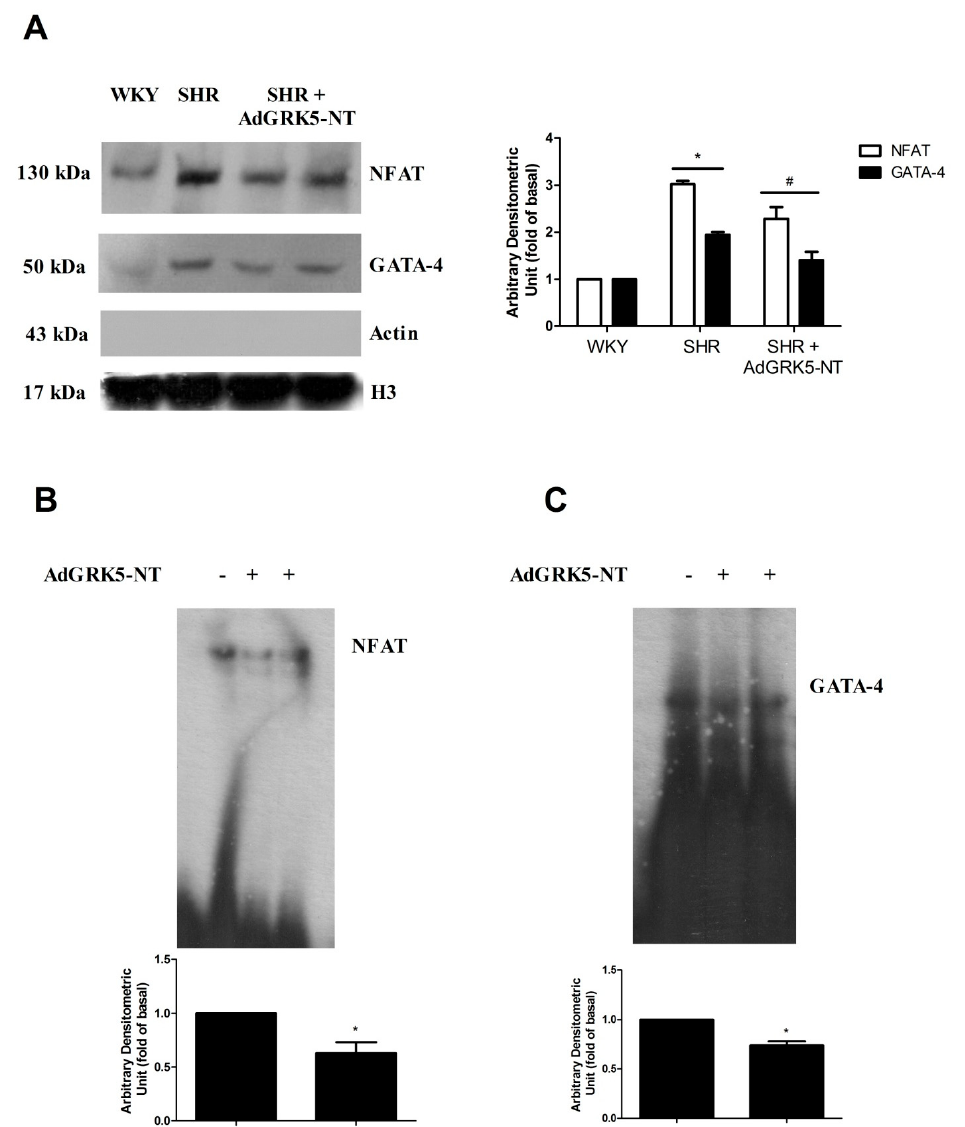
Figure 4. The amino-terminal domain of the G Protein Coupled Receptor Kinase 5 (GRK5-NT) regulates NFAT and GATA-4 activity in vivo. ( A ) The nuclear translocation of NFAT and GATA-4 was evaluated by immunoblot in rat hearts. In hypertrophic SHR rats, there was a significant accumulation of NFAT and GATA-4 in nuclear extracts respect to WKY. The treatment with AdGRK5-NT significantly reduced nuclear translocation of these factors. Densitometric analysis is shown in bar graph as mean ± SD. Actin was used as control of nuclear extracts purity; * p < 0.05 vs. WKY and # p < 0.05 vs. SHR + AdLac-Z; ( B , C ) to confirm the inhibition of transcription factors activity, we analyzed NFAT and GATA-4 ability to bind DNA by EMSA in control and treated SHR. GRK5-NT reduced both NFAT ( B ) and GATA-4 ( C ) activity in response to hypertrophy. All of the images are representative of at least three independent experiments. Densitometric analysis is shown in bar graph as mean ± SD; * p < 0.05 vs. SHR + AdLac-Z.